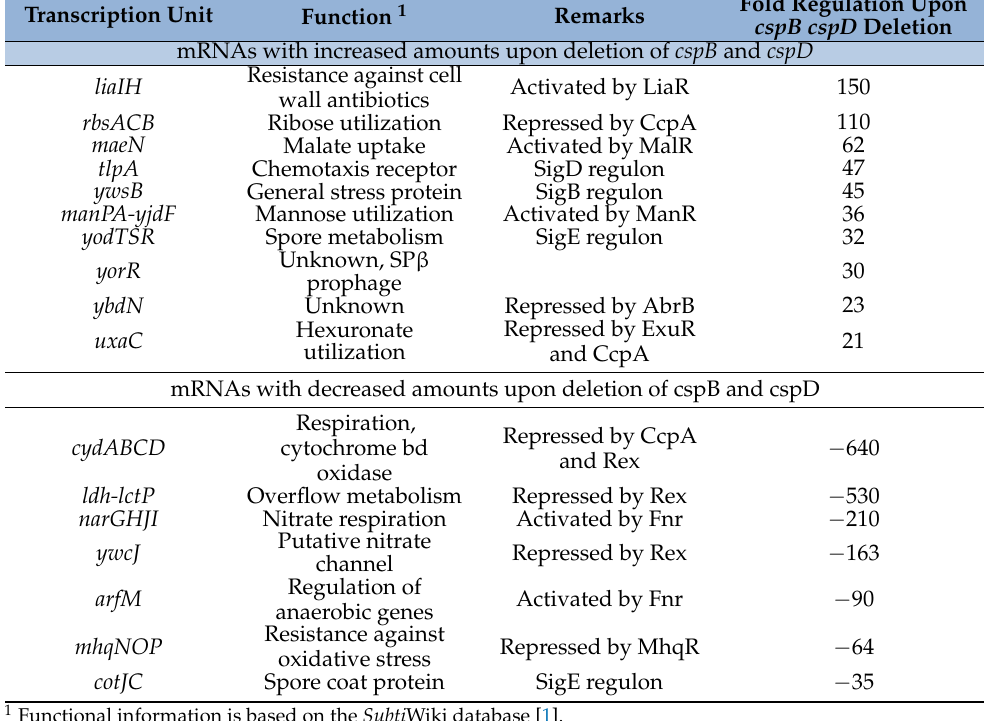
Table 3. Effect of the deletion of cspB and cspD on the expression of B. subtilis genes and